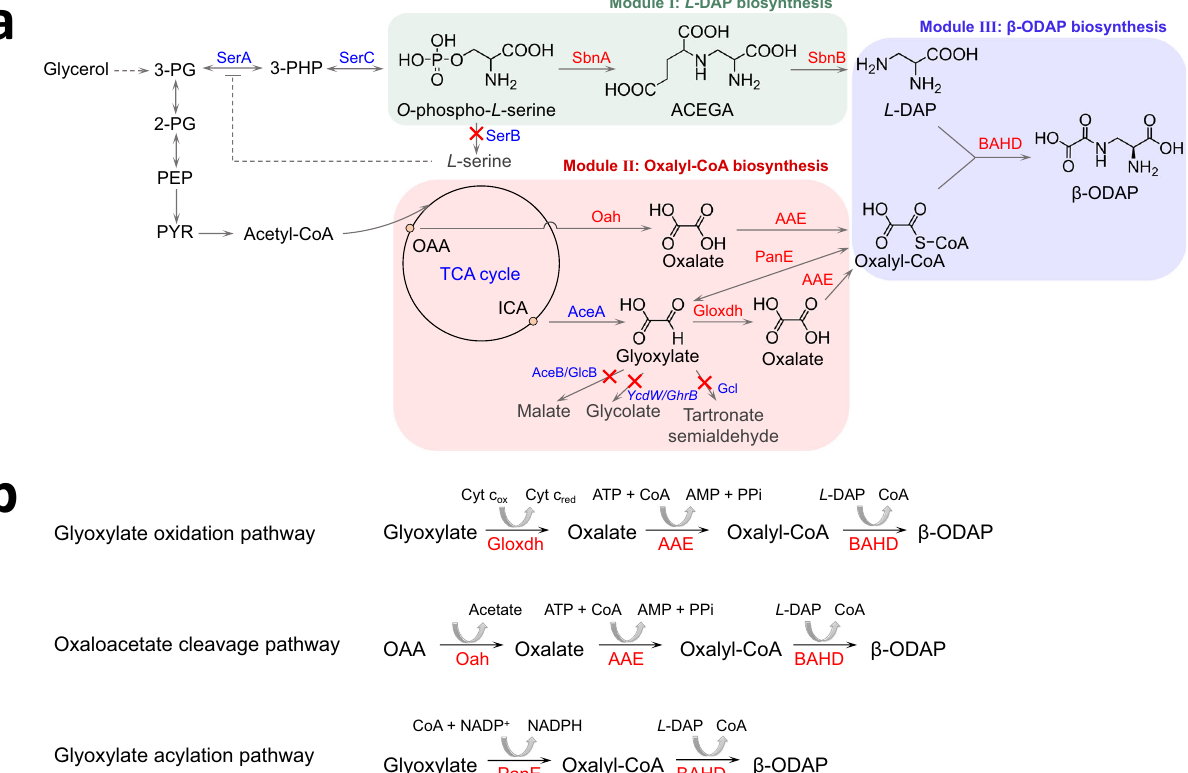
Fig. 1 | Engineered biosynthetic pathways for synthesis of β -ODAP in E. coli . a Pathwaysfor β -ODAPbiosynthesis. b Threepathwaysforoxalyl-CoAbiosynthesis in Module II. Endogenous enzymes are shown in blue and exogenous enzymes are shown in red. The blocked pathways are labeled with red crosses. Enzymes: AAE, acyl-activating enzyme 3; AceA, isocitrate lyase; AceB, malate synthase A; BAHD, dencichine synthase; Gcl, glyoxylate carboligase; GlcB,malate synthase G; Gloxdh, glyoxylate dehydrogenase; Oah, oxaloacetate hydrolase; PanE, oxalyl-CoA reduc- tase; SbnA, N -(2S)-2-amino-2-carboxyethyl- L -glutamate synthase; SbnB, N